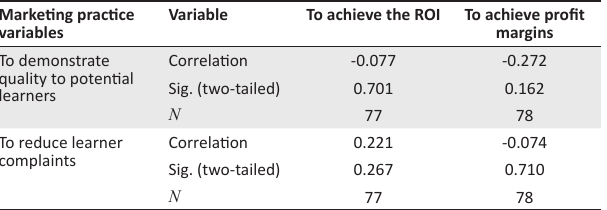
TABLE 4: Effect of marketing practices on both the return on investment and profit margins.